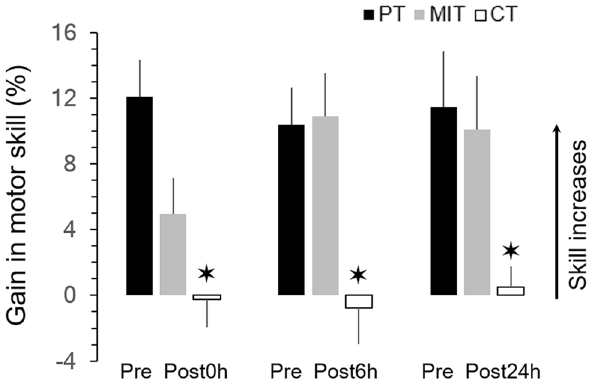
Figure 3. Average values (+ SE) of gains (%) in skill performance between the pretest and the posttest sessions. Star indicates significant differences between the control group and the two other groups (PT and